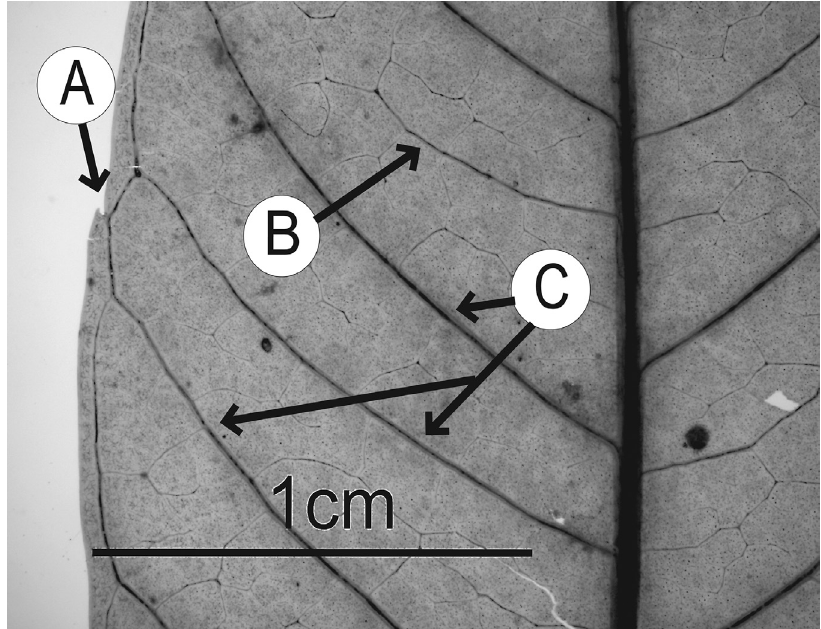
Figure 4. Leaf architecture of Spondias purpurea (contd.). A Tooth B Intersecondary vein C Irregularly spaced, arcuate secondaries. (from Madsen 63428 ,